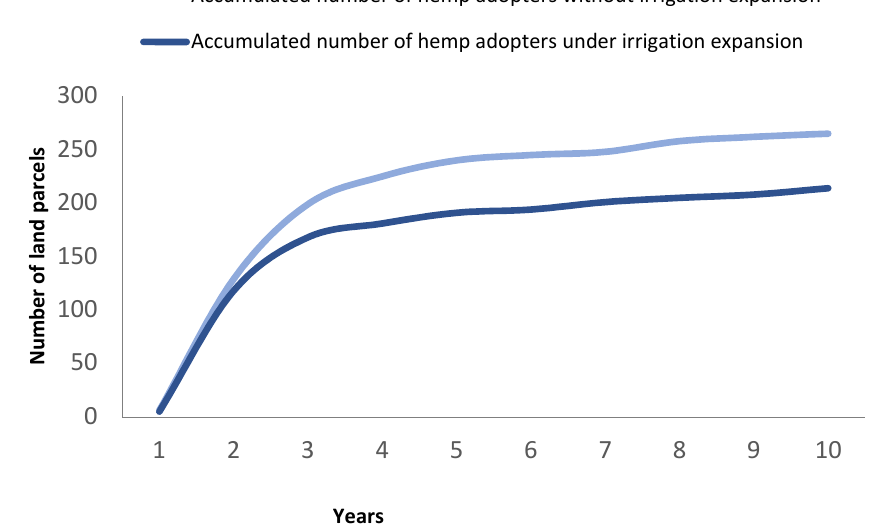
Figure 5. Adoption of hemp crops as irrigation infrastructure becomes available in the Dorset region of north-eastern Tasmania, Australia.